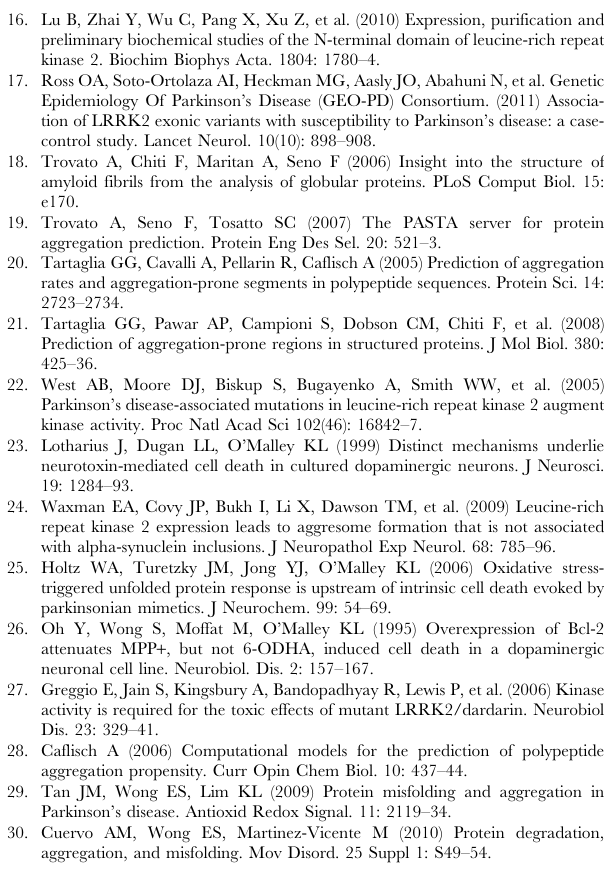
Table S1 Summary of statistical data for figure 2D. Data of Figure 2D were analyzed by one-way ANOVA with Bonferroni post hoc test for multiple comparisons. Table S2 Summary of statistical data for figure 2E. Data of Figure 2E were analyzed by one-way ANOVA with Bonferroni post hoc test for multiple comparisons.